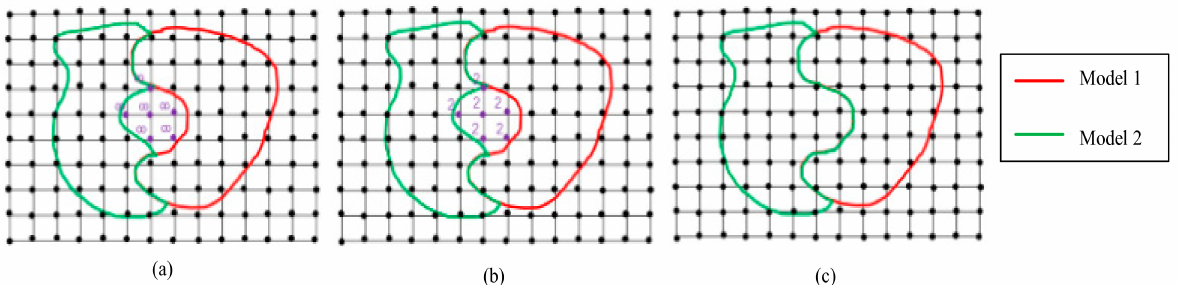
Figure 7. Modify voxel point labels. ( a ) Labels of the void points. ( b ) Modify the labels of the void points. ( c ) Reconstruct the